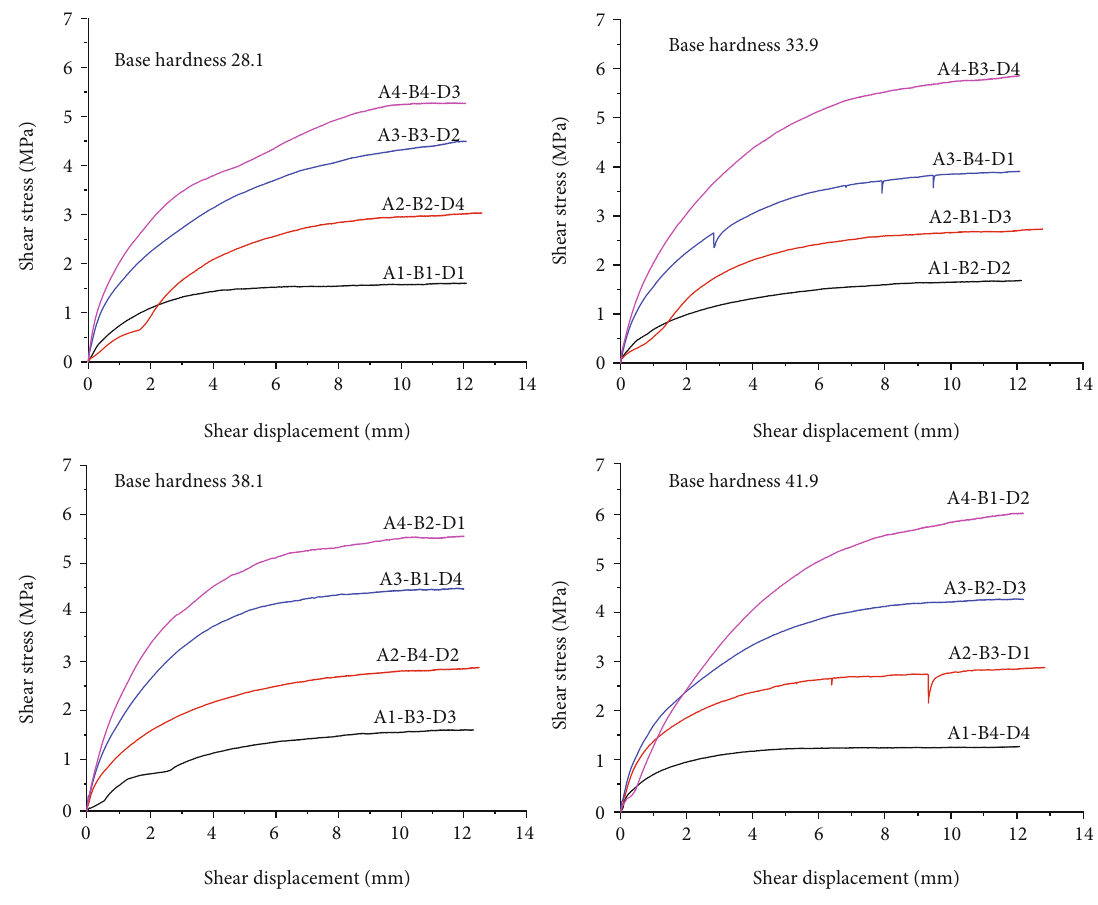
Figure 4: Shear stress-shear displacement curves under di ff erent test schemes. Table 3: Regression results of experimental